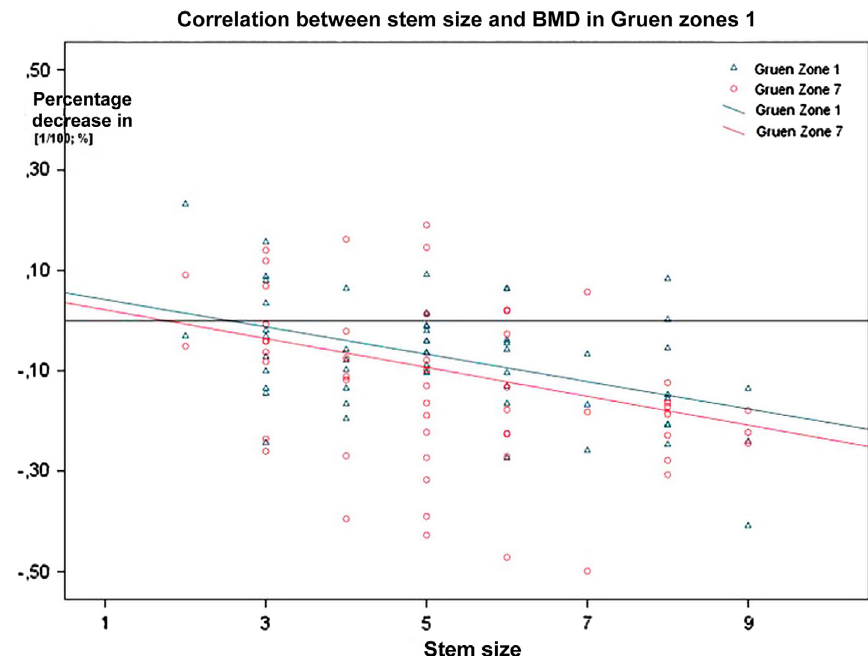
Figure 5. Correlation between stem size and bone density change after one year.